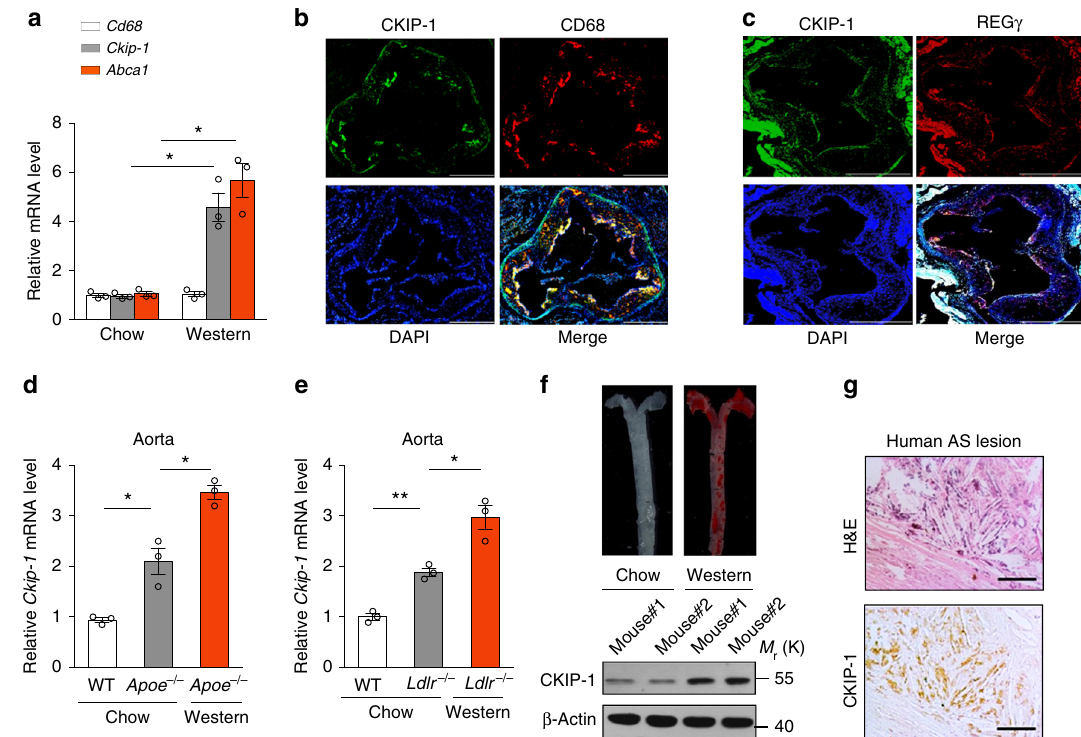
Fig. 4 CKIP-1 is highly expressed in atherosclerotic lesion. a mRNA levels in pM Φ for CD68, CKIP-1, and ABCA1 (control gene) were compared between chow-fed and Western diet-fed Apoe − / − mice. b CKIP-1 expression was detected by immuno fl uorescence staining and located with CD68 in Apoe − / − mouse atherosclerotic lesions (CKIP-1, green; CD68, red; DAPI, blue). Scale bar, 500 μ m. c Immuno fl uorescence staining for CKIP-1 and REG γ in Apoe − / − mouse atherosclerotic lesions (CKIP-1, green; REG γ , red; DAPI, blue). Scale bar, 400 μ m. d CKIP-1 mRNA levels were compared between the aortic arches of chow-fed WT mice and Apoe − / − mice, and between the aortic arches of Apoe − / − mice fed chow or a Western diet. e CKIP-1 mRNA levels were compared between the aortic arches of chow-fed WT mice and Ldlr − / − mice, and between the aortic arches of Ldlr − / − mice fed chow or a Western diet. f Atherosclerotic lesions of chow-fed and western-diet-fed Apoe − / − mice were stained by Oil Red O. CKIP-1 expression in aortic arch of each group was detected by western blot. g Immunohistochemical staining for CKIP-1 in human autopsy atherosclerotic plaques, also stained with H&E to show histological features of the plaque. Scale bar, 50 μ m. Data represent mean ± s.e.m. of n = 3 biologically independent experiments ( a , d , e ). P values were calculated by two-tailed Student ’ s t -test ( a , d , e ). * P < 0.05, ** P < 0.01, *** P < 0.001. The precise P value and statistics source data are in Supplementary Data 2. Unprocessed original scans of blots are shown in Supplementary Fig.